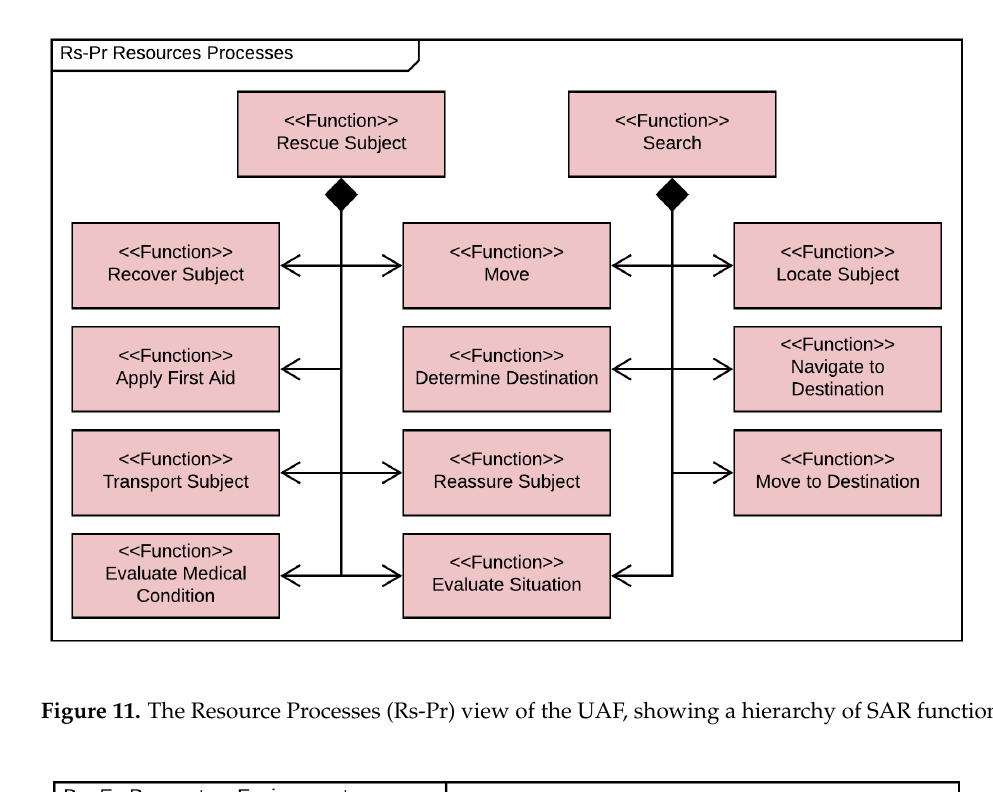
Figure 11. The Resource Processes (Rs-Pr) view of the UAF, showing a hierarchy of SAR functions.